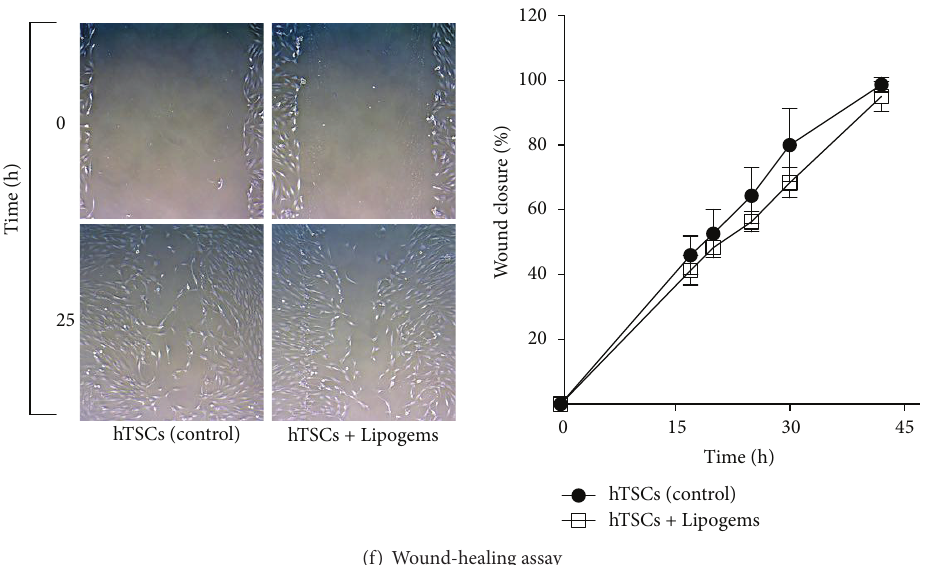
Figure 4: Effects of the Lipogems product on tendon marker expression. (a) Gene expression of TNMD, Tenascin C, and COL1A1 by Real- Time PCR at 96 h of treatment with the Lipogems product. Values are expressed as fold-changes relative to control cells. Effects of the Lipogems product on the in vitro differentiation of hTSCs toward the adipogenic and the osteogenic phenotypes. Adipogenic and osteogenic differentiation ability of hTSCs cultured with the Lipogems product in the appropriate differentiation medium was evaluated by Oil Red O (b) and Alizarin Red-S (c) staining, respectively. (b) Lipid intracellular droplets (red) in the adipocytes were stained with Oil Red O solution. (c) Alizarin Red-S staining revealed the presence of calcium deposits (yellowish-brown). Typical results are shown. Original magnification × 10. Effect of Lipogems treatment on stem cells marker (Nanog, Oct4, and KLF4) (d) and VEGF (e) expression by Real-Time PCR at 96 h of treatment with the Lipogems product. Values are expressed as fold-changes relative to control cells. Effect of the Lipogems product on hTSCs migration. (f) Representative time-lapse migration images of control and Lipogems-treated cells. Images were acquired at 0 and 25 h in in vitro wound-healing assay. Original magnification × 5. The migration rate was measured by quantifying the total area of the wounded region lacking cells. The average percentages of recovered area obtained from three different experiments at 17, 20, 25, 30, and 42 h of treatment with the Lipogems product, as compared to control cells. All quantitative data are expressed as the means ± SD of three different experiments. 𝑝 values were calculated using Student’s 𝑡 -test. Only 𝑝 values < 0.05 are indicated: ∗∗ 𝑝 < 0.01 , compared to control